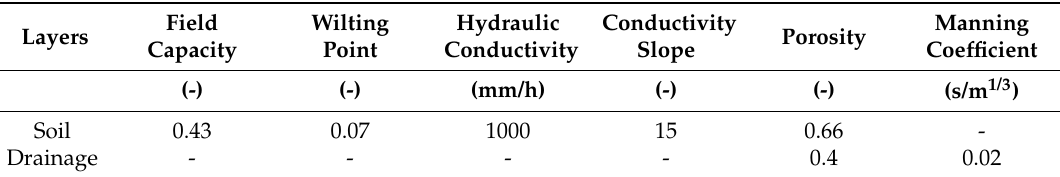
Table 3. Green roof parameters assigned in the Storm Water Management Model (SWMM)—low impact development (LID) control section. Layers